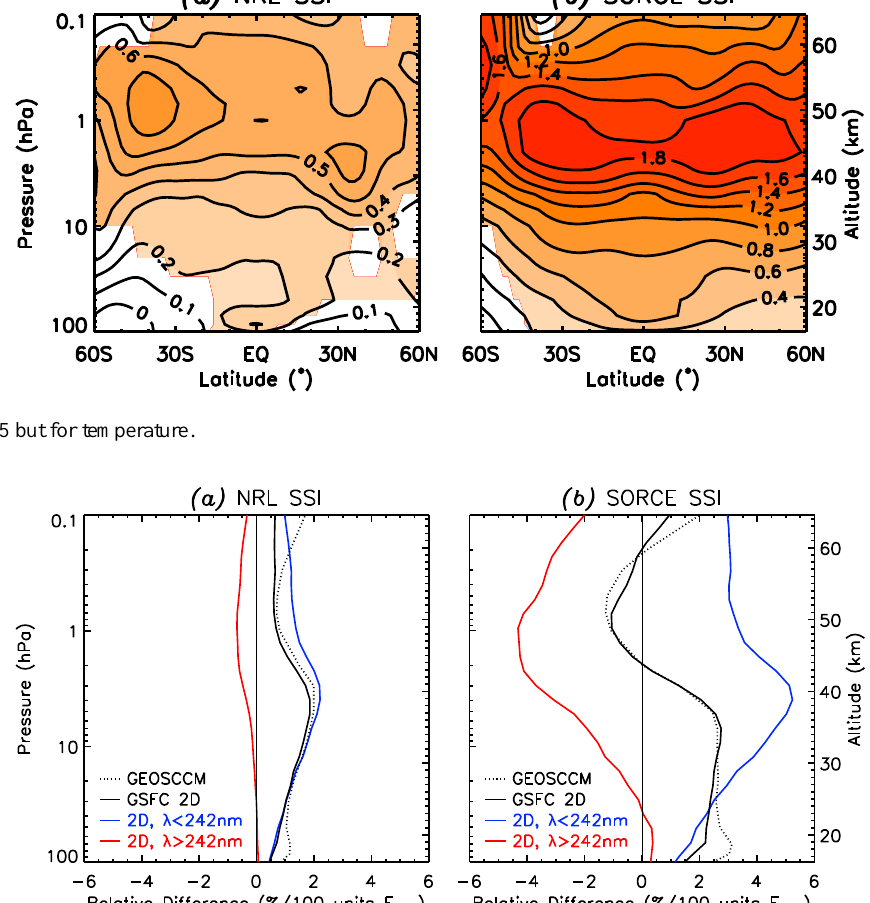
Fig. 9. Simulated ozone response to the solar cycle at wavelengths less and greater than 242nm using both (a) NRL and (b) SORCE SSI in the GSFC 2-D model, along with the total responses, averaged over 60 ◦ S–60 ◦ N latitude. Also shown are the analogous GEOSCCM total responses (corresponding to the simulations in Fig. 4 but averaged over 60 ◦ S–60 ◦ N) for